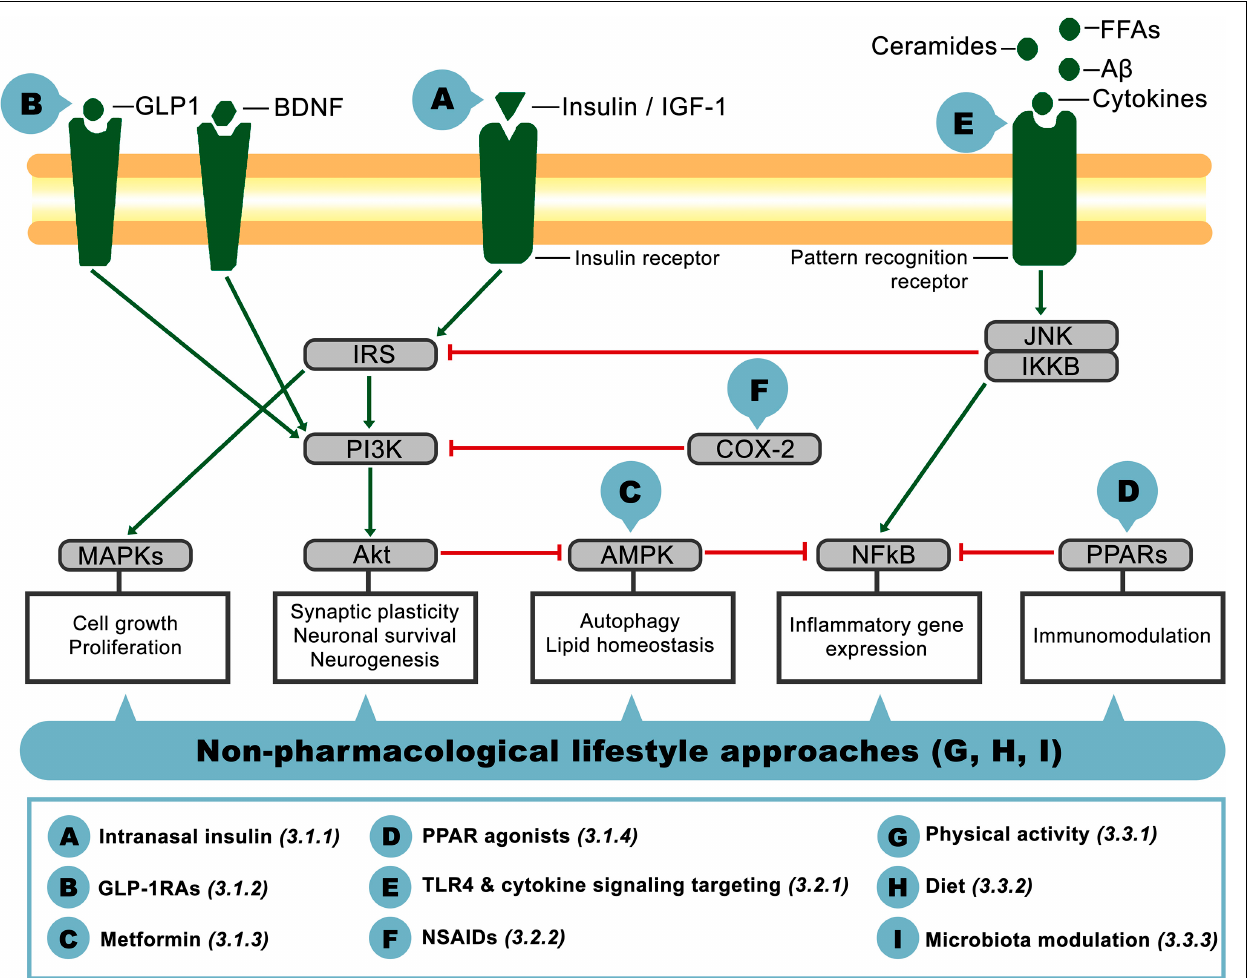
FIGURE 2 | Schematic representation of interacting components of the insulin signaling and inflammatory pathways on the brain. Pointed-head arrows depict activation and blunt-end arrows inhibition, while letter circles A-I point the level at which the potential therapeutic approaches discussed in this article would act. Treatment definition and corresponding reference section are defined in the inferior